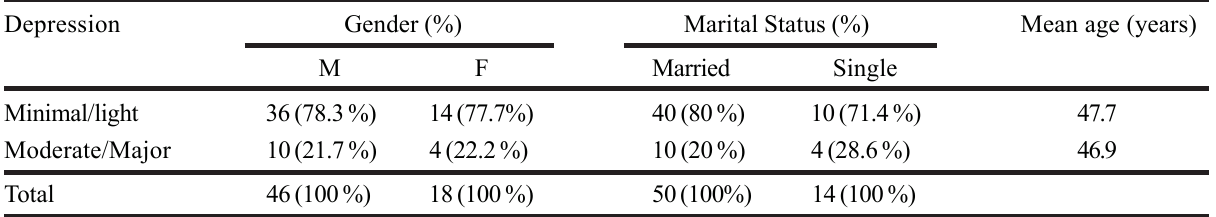
TABLE 1 - Correlation between demographic data and the level of depression in patients listed for liver transplantation Depression